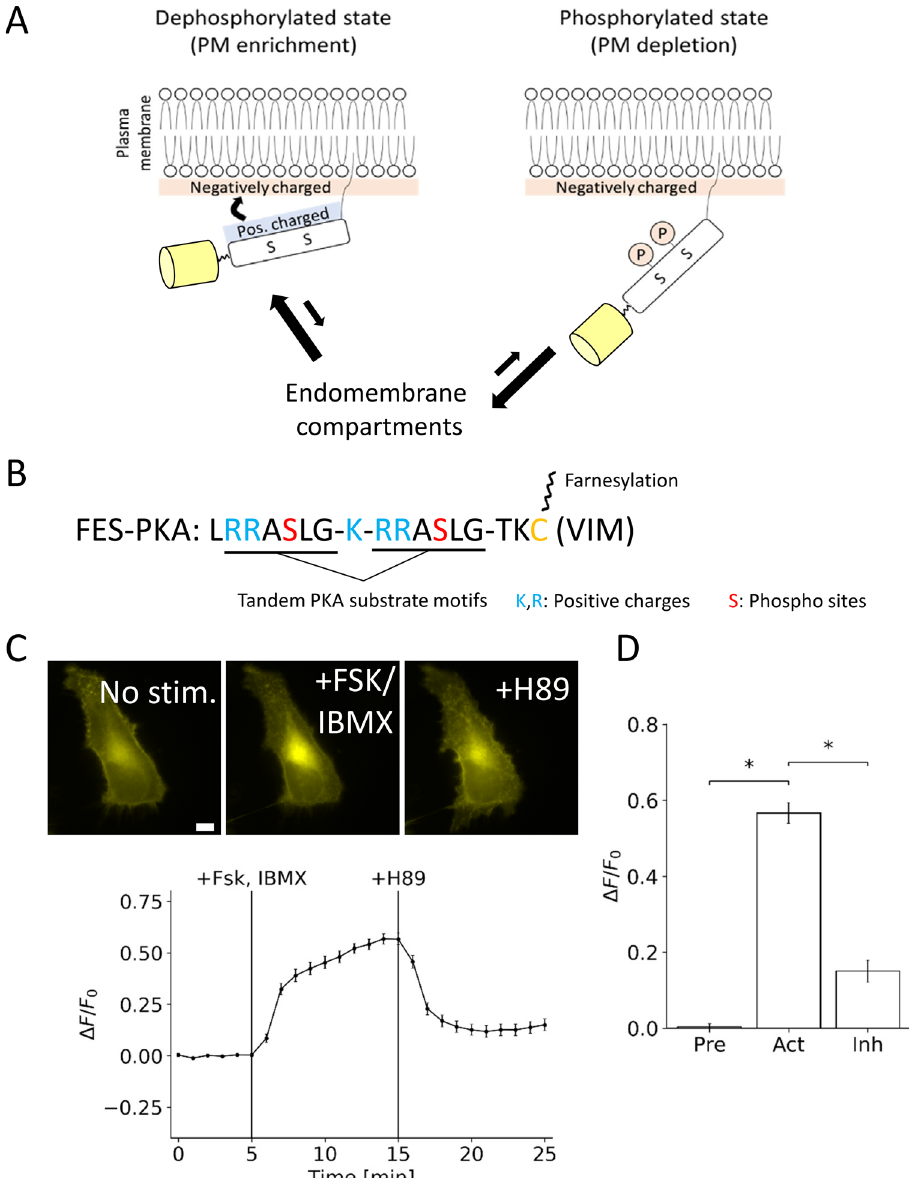
Figure 1. Basic Design and characterization of the Synthetic Farnesyl-Electrostatic Switch. (A) Plasma membrane targeting of farnesylated proteins relies on the presence of positively charged residues near the C-terminus. The farnesyl-electrostatic switch relies on the regulation of this sequence through phosphorylation. Yellow cylinders indicate a fluorescent protein for visualization. (B) Design of a farnesyl-electrostatic switch for PKA activity (FES-PKA) that consists of positive charges, two phosphate acceptors, and a CAAX tail which undergoes multi-step modifications including farnesylation. (C) Time-profile shows the quantification of the fluorescent signal in response to PKA activation and reversal with PKA inhibition. Representative micrographs of cells are shown on top in the following states: pre-treatment, post-activation, and post-inhibition. Fluorescence intensity of FES-PKA at the endomembranes at a given time point ( F ) was divided by that of time 0 ( F 0 ). The resulting value ( F / F 0 ) was then normalized to that of time 0, and used as an indicator of relative redistribution of FES-PKA in (C) and (D). All data points represent an average signal intensity collected from 30 cells over 3 independent experiments (10 cells each), and error bars represent standard error of mean. Scale bar represents 10 µm. (D) Bar chart represents the signal change pre-treatment (at 5 min), post-treatment with FSK + IBMX (at 15 min), and washout with H89 (at 25 min), respectively. * represents statistical significance: p <